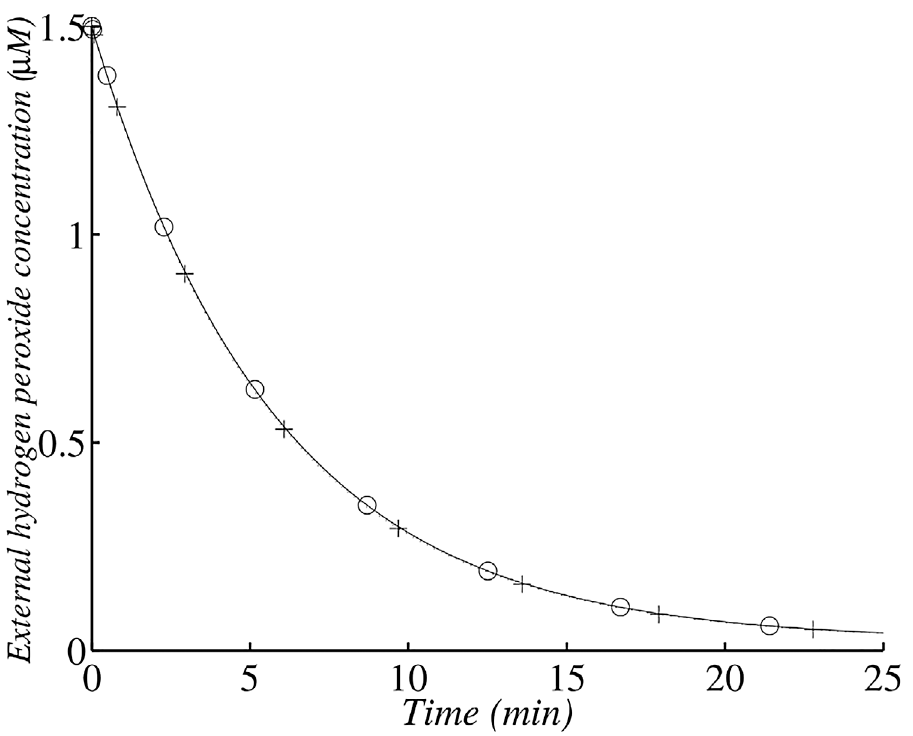
Fig 8. Changes in external H 2 O 2 concentration in the wild type after the addition of 1.5 μ M exogenous O H 7 cells ml − 1 . (+) corresponds to the analytical solution according to the simplified system 2 2 with 1.45 × 10 and ( (cid:10) )) corresponds to the numerical solution of the whole model. The simulation was run with 1.45 × 10 7 cells ml − 1 (corresponding to an OD 680 value of